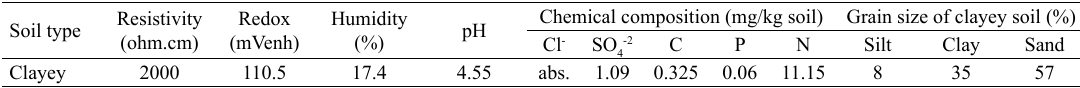
Table 1. Physical-chemical analysis and grain size of clayey soil. Soil type